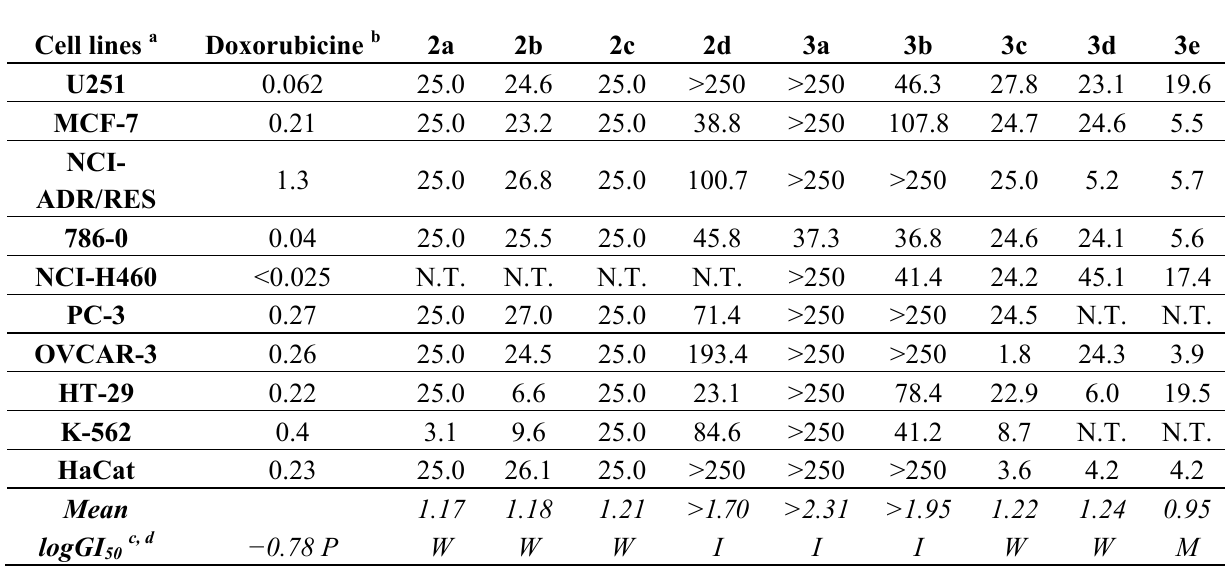
, μ g/mL) of 2a – d and 3a – e on human cell lines. 50